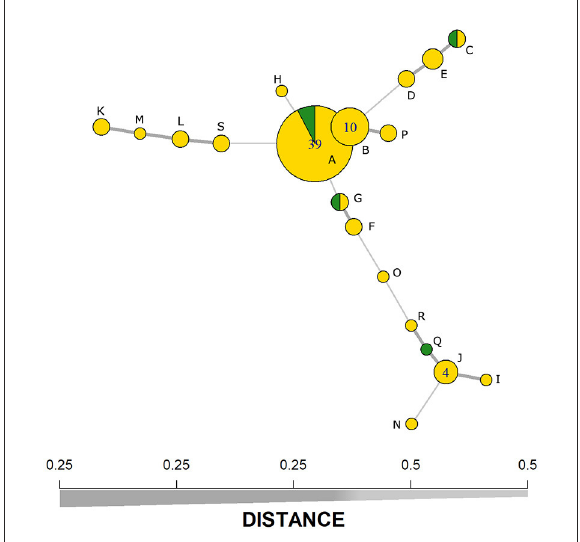
FIGURE1 Minimum-spanning tree based on five MIRU-VNTR markers representing the clustering of 79 Mycobacterium avium subspecies paratuberculosis (MAP) isolates from subpopulation 1 (yellow) and subpopulation 2 (green). Line thickness represents the genetic distance between the haplotypes (x-axis). Alphabetic letters represent the haplotypes as presented in Table